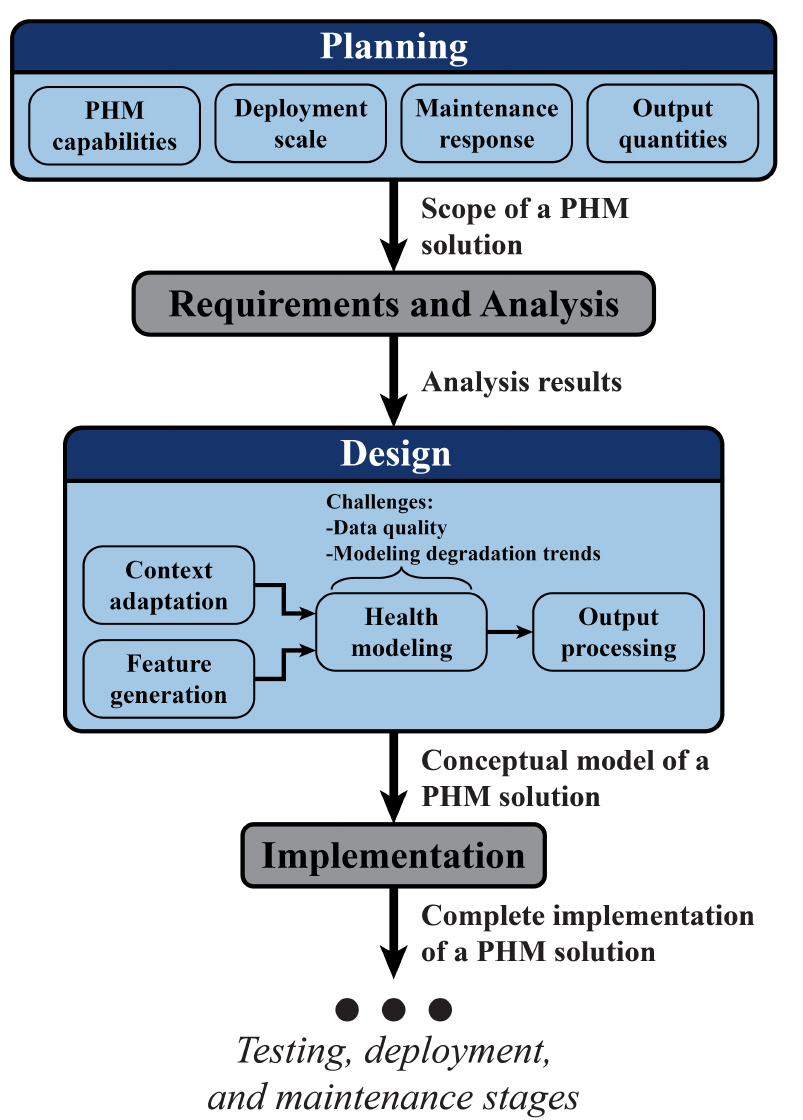
Figure 1. Early stages of the software design life cycle for industrial PHM solutions. This paper will discuss the planning and design stages in